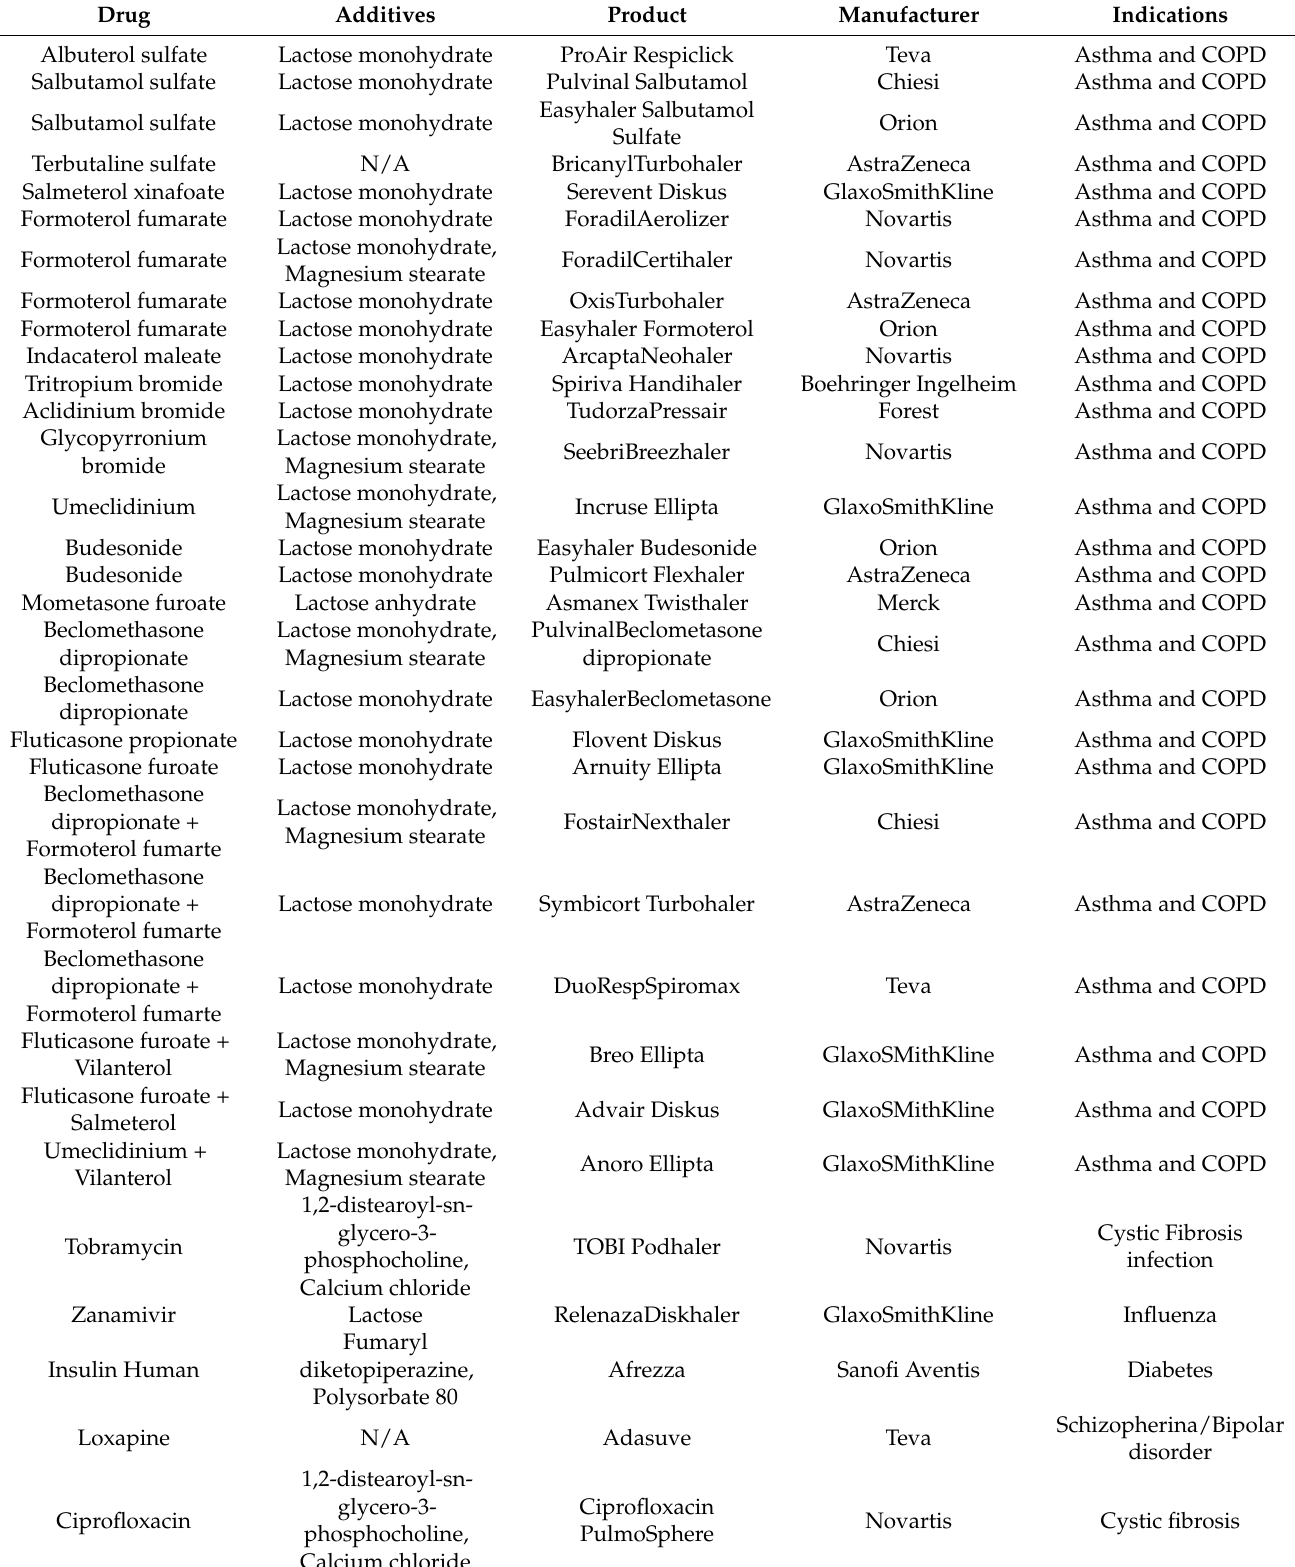
Table 3. DPI formulations available in the market of the USA and other